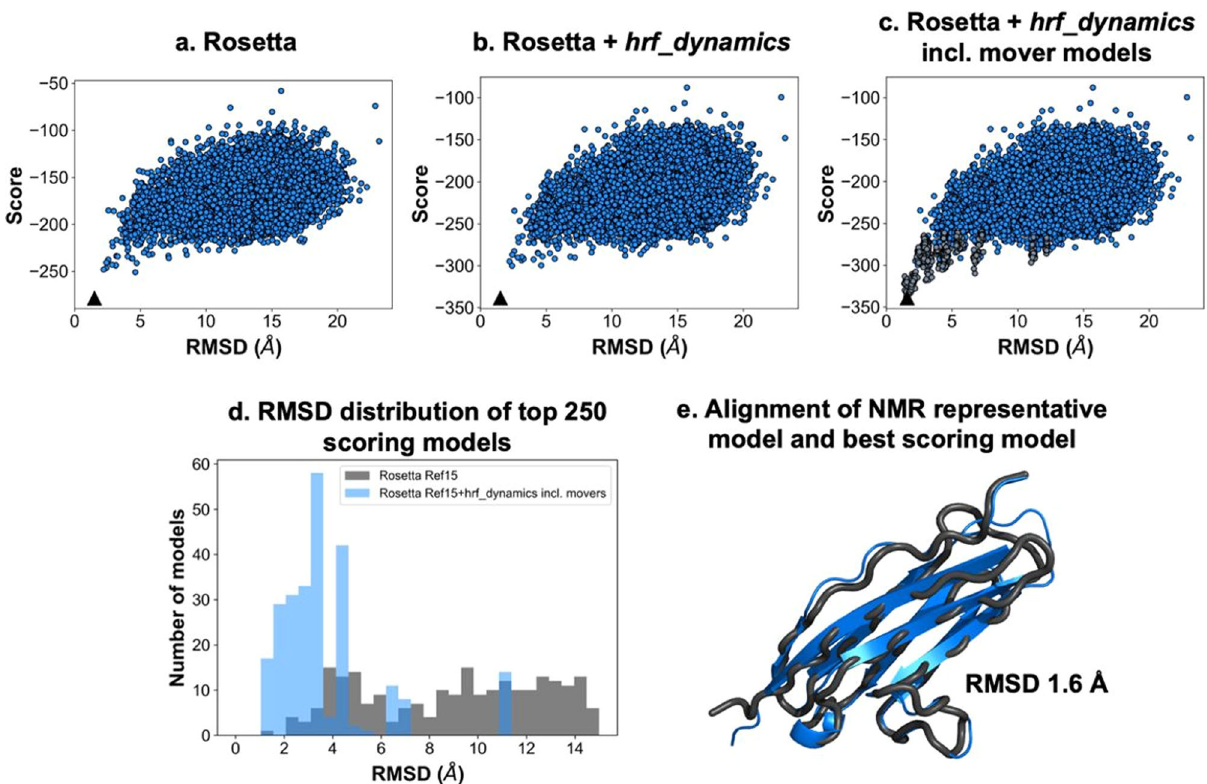
Fig. 2 Ab initio modeling of NRG1-Ig with relaxation ensemble and FPOP-guided scoring signi fi cantly enriched high-quality models. Score versus RMSD to NMR model 1 when ( a ) scoring with Rosetta ’ s score function; ( b ) scoring with Rosetta and hrf_dynamics ; and ( c ) scoring with Rosetta and hrf_dynamics including mover models (dark grey). Best scoring models are denoted by a black triangle. d RMSD histograms for top 250 scoring models when scoring with Rosetta (grey) versus Rosetta and hrf_dynamics including mover models (blue). Bin widths were maintained at 0.5 Å. e Alignment of NMR model 1 (black) with the top-scoring model identi fi ed from our HRPF-guided and mover model protocol (blue). The RMSD to the NMR model was determined to be 1.6